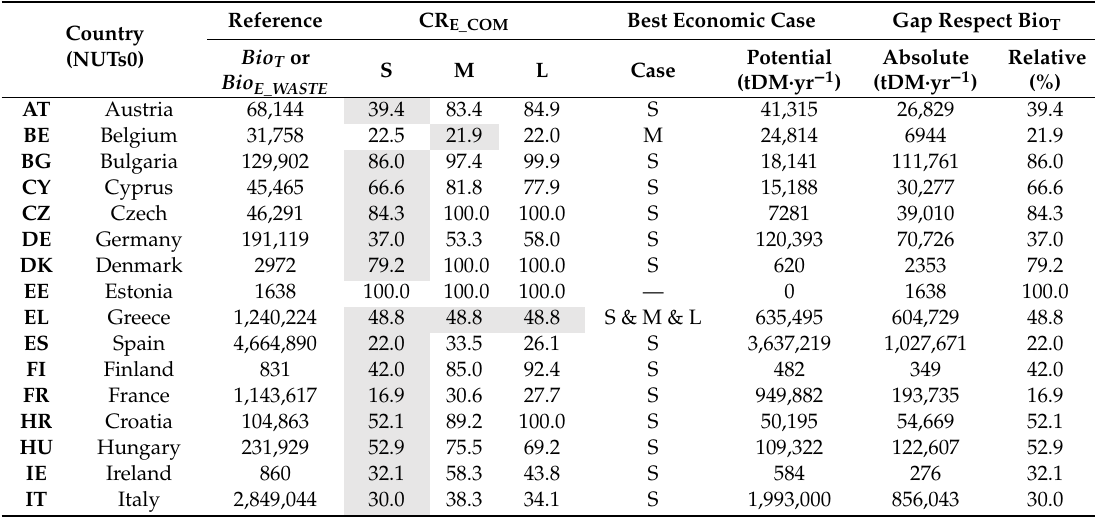
Table 8. Best economic exploitation system for pruning utilisation on a commercial